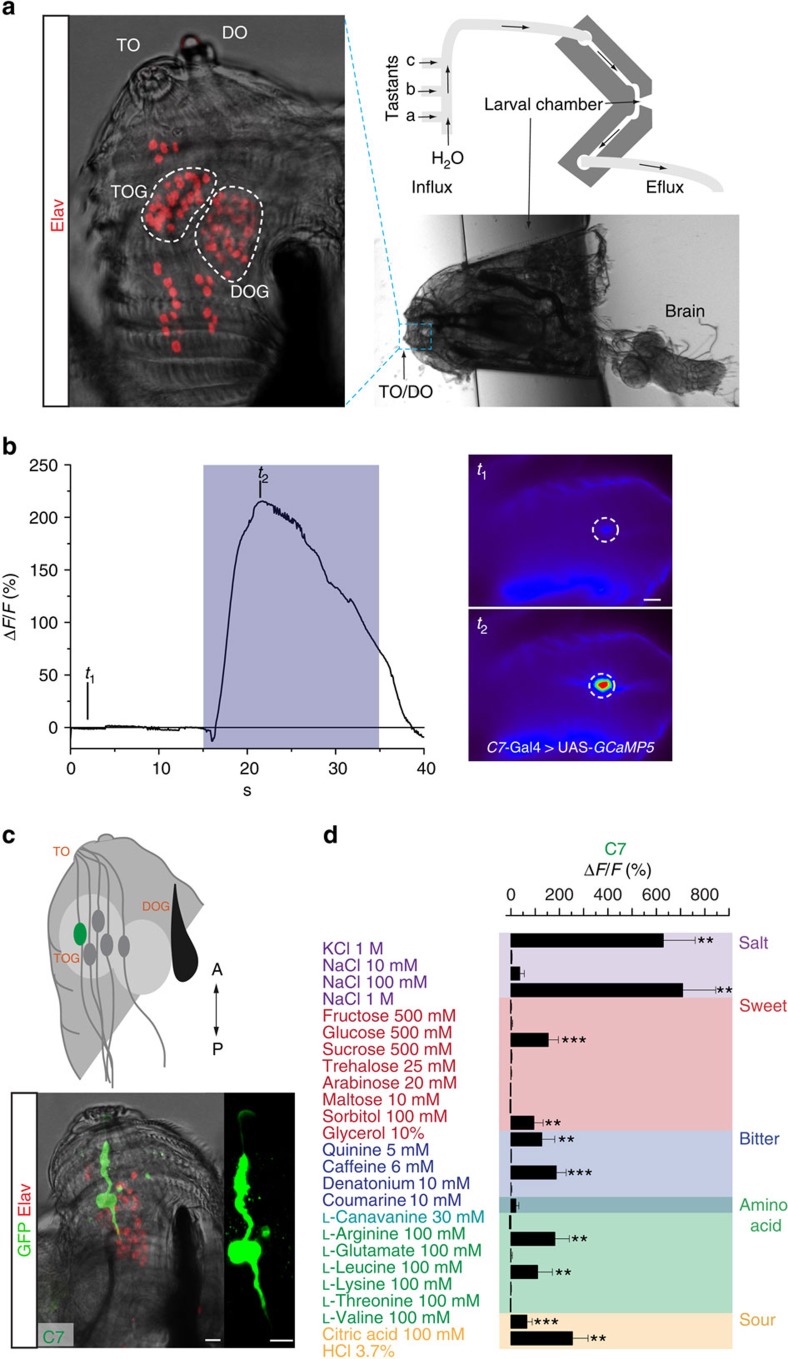
The physiological response of C7 was measured in a specific microfluidic device using genetically encoded calcium sensor GCaMP5.(a) Elav staining and bright-field image of larval head showing the DO and the TO as well as the related ganglia DOG and TOG. Schema and bright-field image of the microfluidic device. Solutions can be pumped through the influx channels and stimulate the larval chemosensory organs. (b) Exemplary measurement of stimulation (NaCl 1 M) of the GMR57B04ppk6 (C7) neuron with GCaMP5 shows the relative change of fluorescence (ΔF/F (%) see materials and methods) for two different time points in false colouration (t1=beginning of the measurement before stimulation, t2=maximum of fluorescence change during stimulation). (c) Schematic depiction of the selected GRN and staining of GMR57B04ppk6-Gal4 crossed with UAS-mCD8::GFP. (d) C7 shows neuronal responses to multiple stimuli from different taste categories. Changes of fluorescence for a panel of substances measured in the C7 neuron (n=5–9). Scale bars, 10 μm. Error bars show the s.e.m. and significances are indicated as following: ***P<0.001 and **P<0.01 in Wilcox signed rank test, samples compared with the baseline when water only was applied.